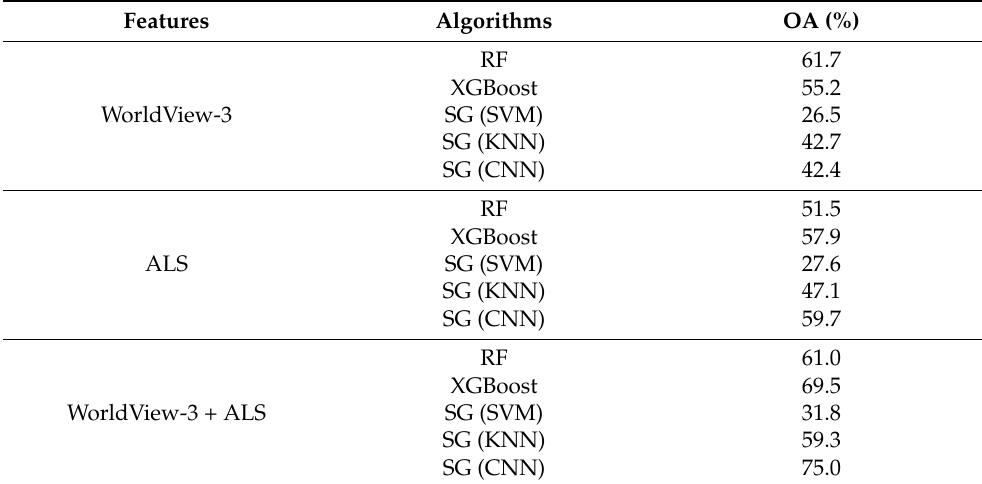
Table 6. Tree species classification performance of the ensemble learning algorithms.